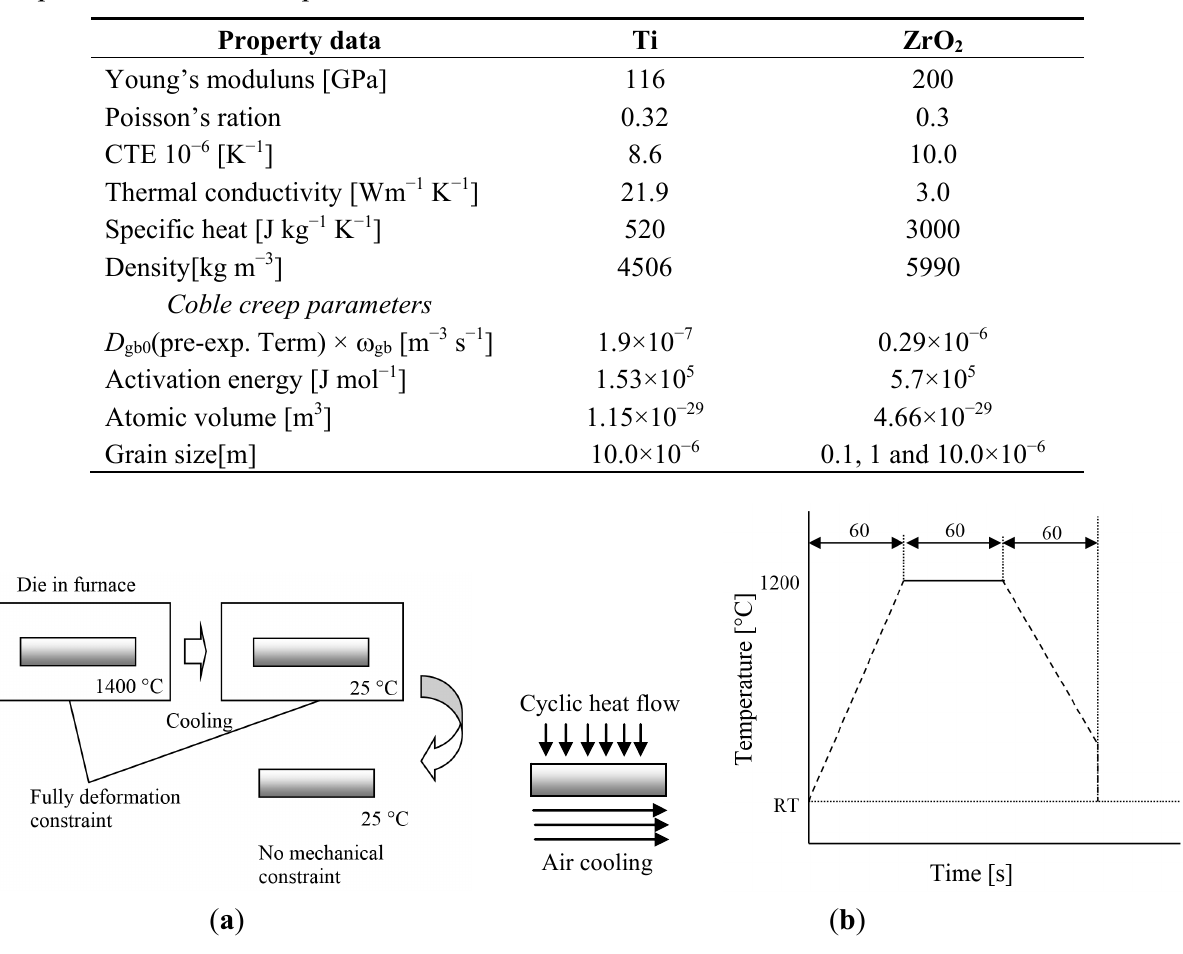
Figure 3. Schematic illustration of thermo-mechanical boundary conditions for fabrication and thermal cycling processes: ( a ) fabrication process, and ( b ) thermal cycling process, including a schematic illustration of heat flow and temperature profile for one